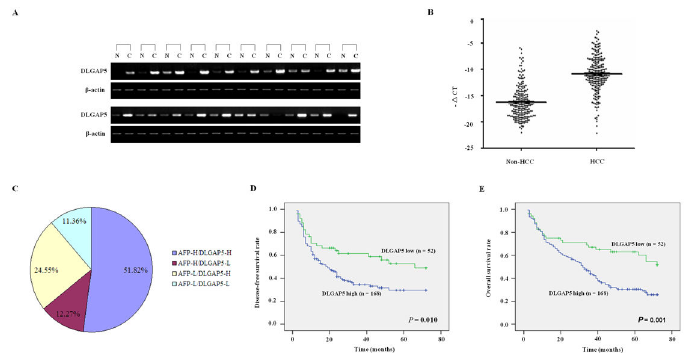
Figure 1. mRNA expression pattern of DLGAP5 in HCC specimens. (A) Representative results of the semi-quantitative RT- PCR analysis of DLGAP5 in 20 pairs of HCC (C) and adjacent non-cancerous liver tissues (N). β-Actin was used as an internal control. Each PCR was performed for 35 cycles, and the PCR products were visualized by electrophoresis on 2% agarose gels. (B) Real-time RT-PCR analysis of DLGAP5 in 220 paired HCC and adjacent non-cancerous liver tissues. For each sample, the relative mRNA level of DLGAP5 was normalized to the level of β-actin. The line within each box represents the median –ΔCt value; the upper and lower edges of each box represent the 75th and 25th percentile, respectively; the upper and lower bars indicate the highest and lowest values determined, respectively. (C) The distribution of the DLGAP5 and AFP expression levels in the 220 HCC specimens. The numbers indicate the percentages of DLGAP5- and/or AFP-positive HCC specimens, as detected by real-time RT- PCR. (D)/(E) Disease-free survival rate (D) and Overall survival rate (E) of patients with HCC. High expression of DLGAP5 mRNA was significantly associated with worse prognosis ( P =0.010). DLGAP5 high: 2 −ΔΔCT >1 (or –ΔΔCT>0); DLGAP5 low: 2 −ΔΔCT ≤1 (or